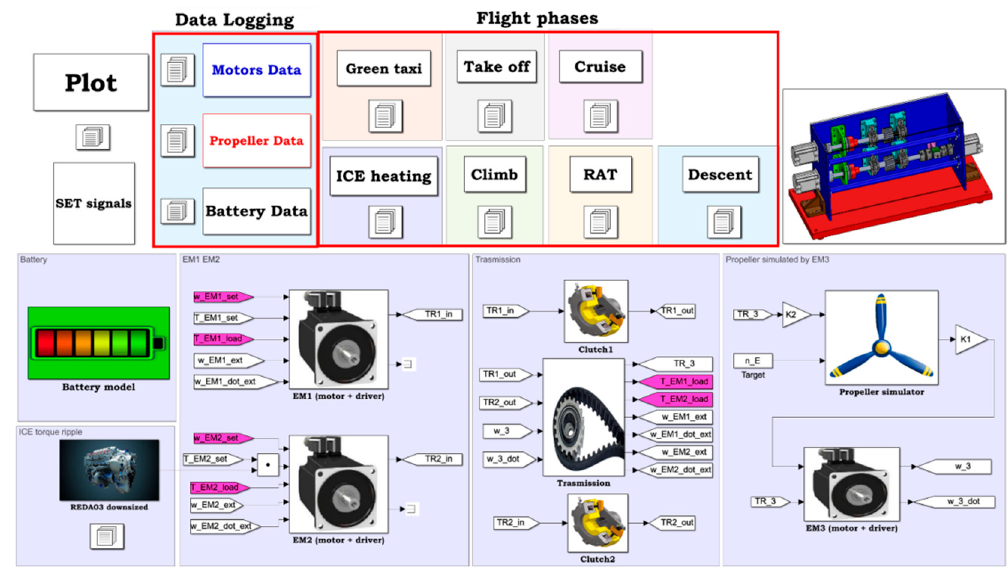
Figure 11. The virtual test bench. Table 2. Requirements for the real hybrid propulsion system.